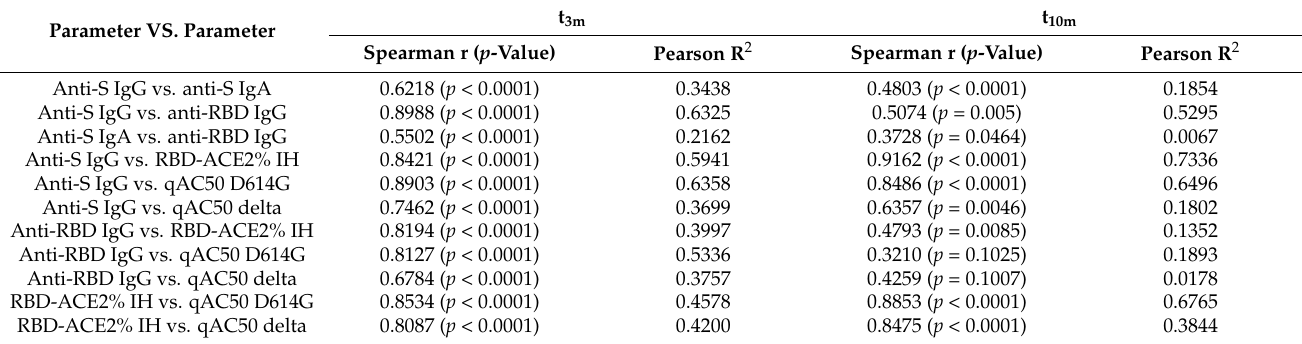
Table 1. Correlation of SARS-CoV-2-specific humoral parameters measured after BNT162b2 vaccination. Parameter VS.